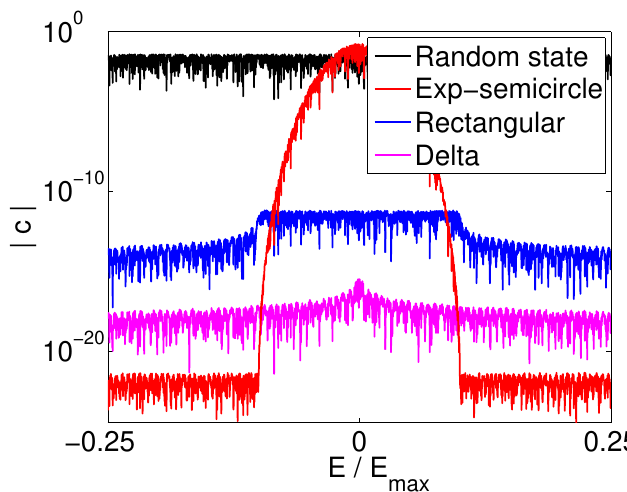
Figure 2: Comparison of the effect of three different filters in the interval [ − 0.25,0.25 ] . We present the initial random normalized state | ψ 〉 = (cid:80) curve) and the final normalized states after the filtration by the exp-semicircle filter with K = 240 (red curve) and the Chebyshev expansion of the rectangular function Θ ( x + 0.1 ) Θ ( − x + 0.1 ) with order K = 480 (blue curve) and the Dirac delta function δ ( 0 ) with K = 480 (pink curve). The parameter a = 0.1 for the exp-semicircle fil- ter. The x -axis corresponds to the “reduced energy" E / E absolute value of the probability amplitudes c by 10 − 10 while the delta function is shifted by 10 − 15 . All three filters share the same number of matrix-vector products. The advantage of the exp-semicircle filter is ob- vious, considering the amplification of the target